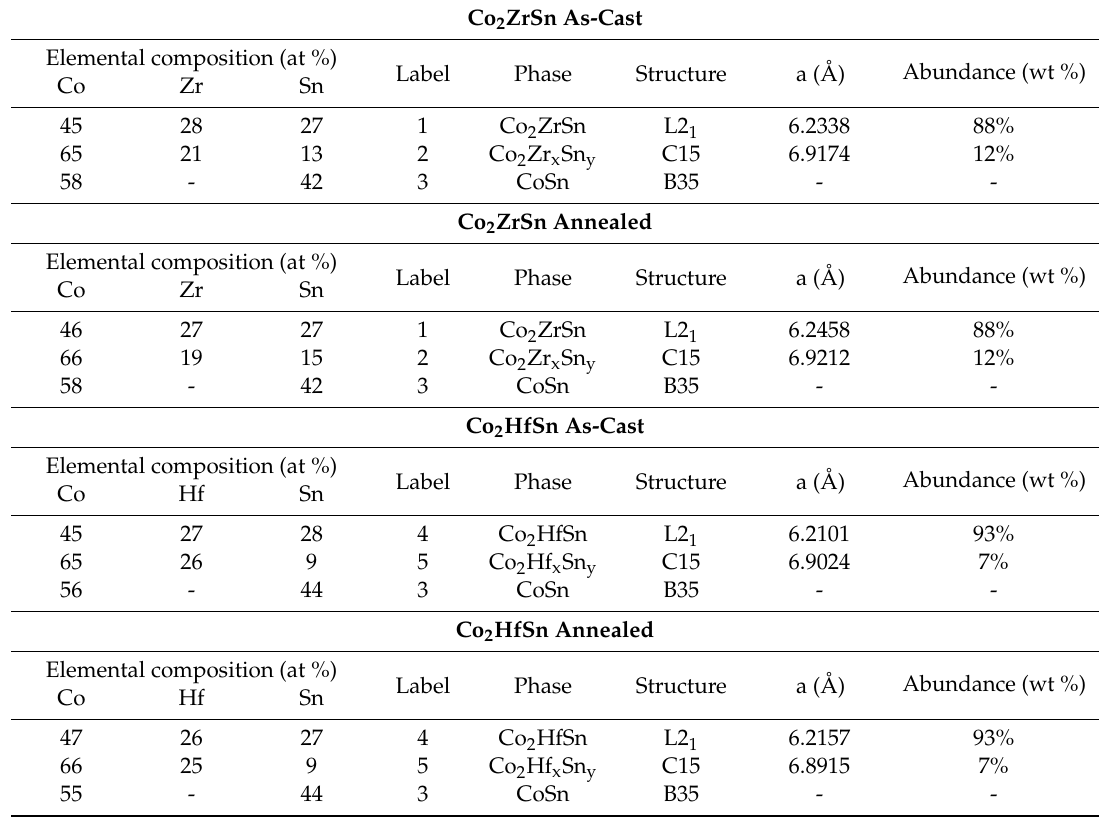
Table 1. Composition, prototype–structure, cell parameters, and relative abundances of the di ff erent phases in the Co 2 ZrSn and Co 2 HfSn samples. The structure of the phase 3, CoSn, is shown as reported in the Co-Sn phase diagrams